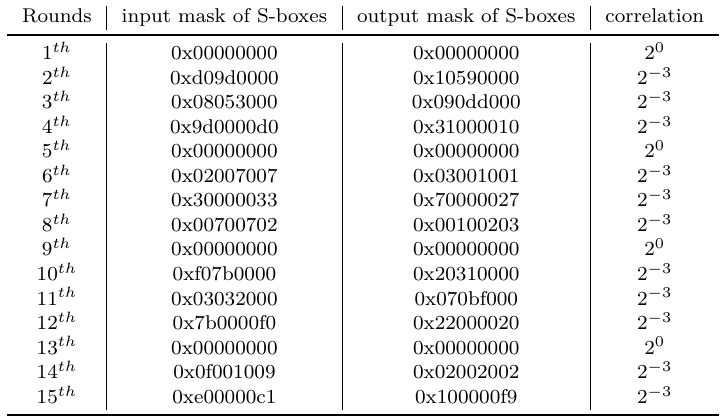
Table 15: The best linear characteristic with correlation 2 − 33 for 15-round